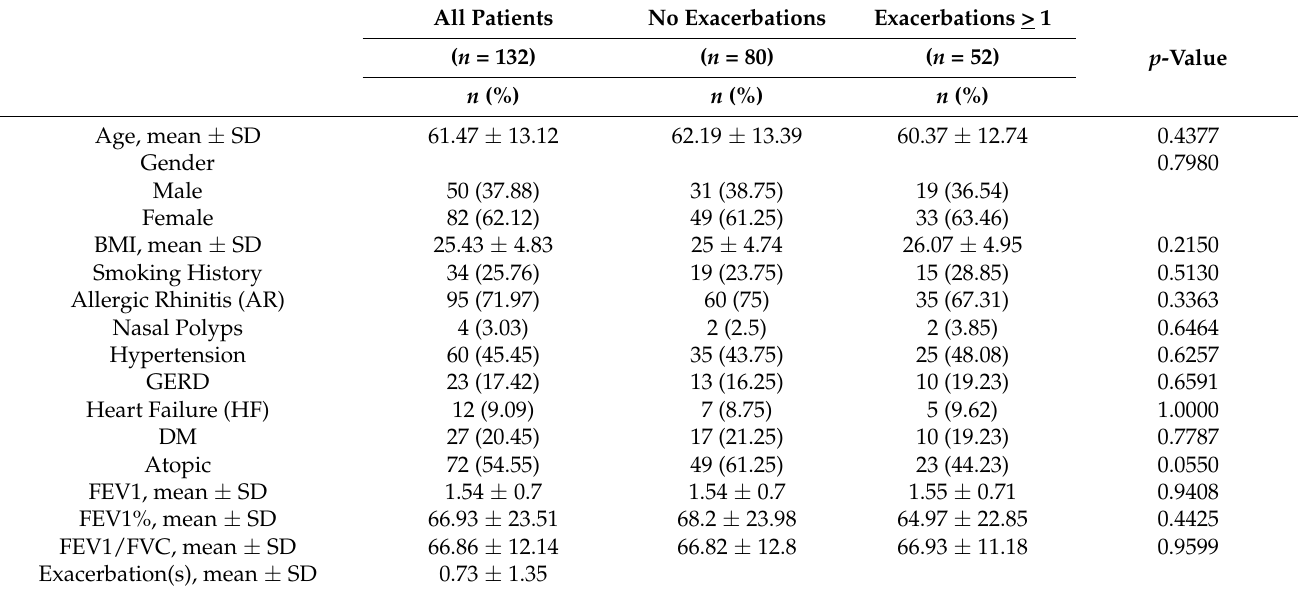
Table 1. Demographic and clinical characteristic of severe asthma